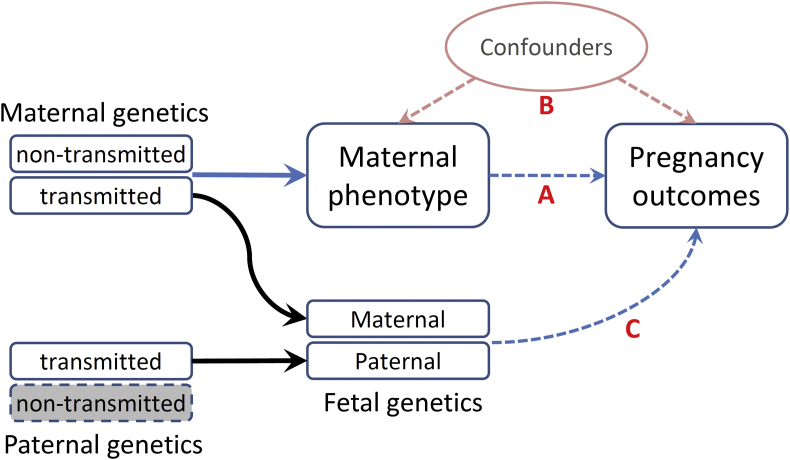
Possible causal mechanisms that can lead to the observational associations between a maternal phenotype and pregnancy outcomes. (A) Direct causal effect (maternal effect) of maternal phenotype on pregnancy outcomes. (B) Associations of social and nutritional confounders that have impacts on both maternal phenotype and pregnancy outcomes. (C) Fetal genetics that directly influences pregnancy outcomes.